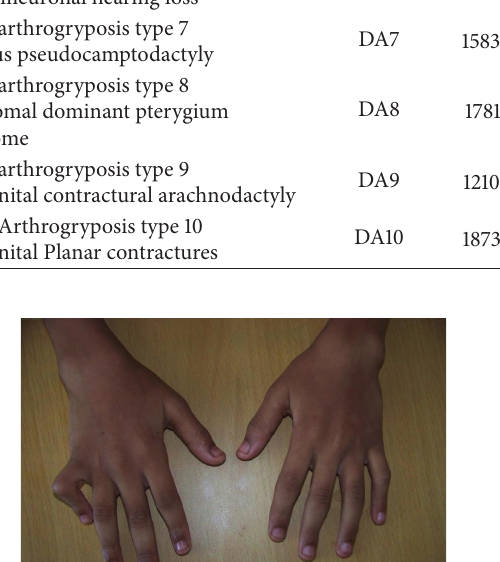
Figure 2: Photograph of feet showing contracture of all the toes and valgus deformity of the feet.